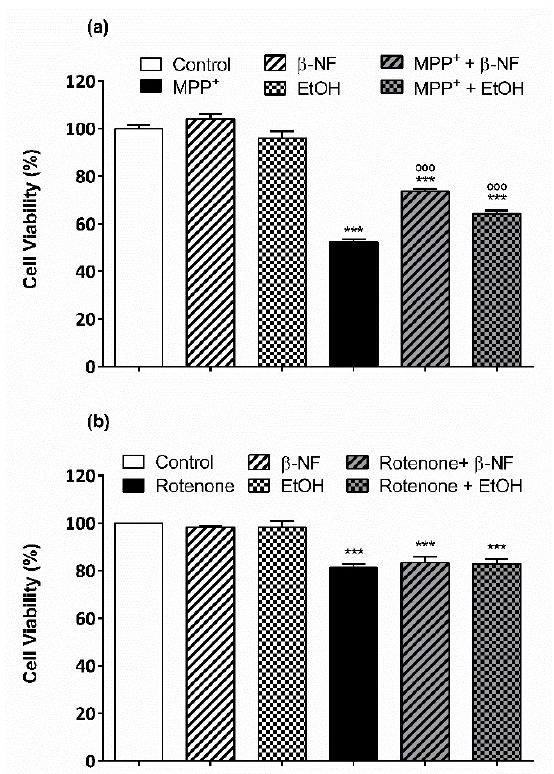
Figure 8. β-NF and EtOH treatments partially protect SH-SY5Y cells towards MPP + exposure but not against rotenone. SH-SY5Y cells were pretreated with β-NF or EtOH for 24 h and with 600 µM MPP + ( a ) or 0.2 µM rotenone ( b ) for the following 24 h. No treatment was performed in control cells. Viability was tested by tetrazolium (MTT) assay as described in materials and methods. Each column represents the mean ± SEM of at least three independent experiments. Data was normalized by taking control values as 100% of metabolic activity, and then compared for significance to control samples (*) and to MPP + or rotenone controls (°). Statistical significance was analyzed by one-way ANOVA followed by a Tukey post-test. *** p < 0.001 with respect to controls; °°° p < 0.001 with respect to MPP + or rotenone.